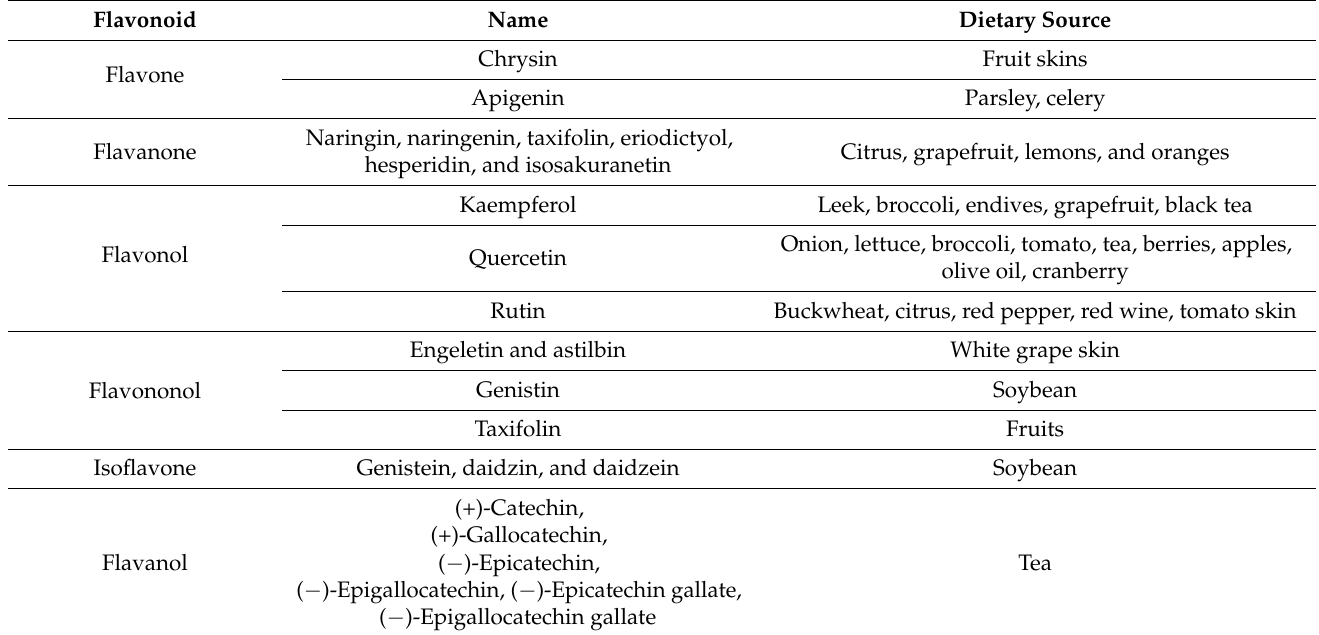
Table 2. Different classes of flavonoids and dietary sources. Adapted from